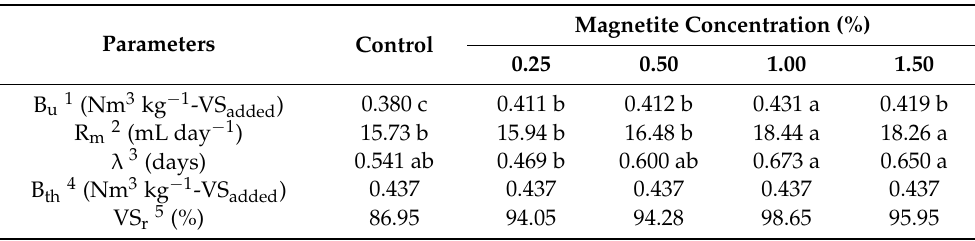
Table 4. Analysis of methane yield characteristics by the modified Gompertz model at different concentrations of magnetite (Fe 3 O 4 ). Magnetite Concentration (%) Parameters Control 0.25 0.50 1.00